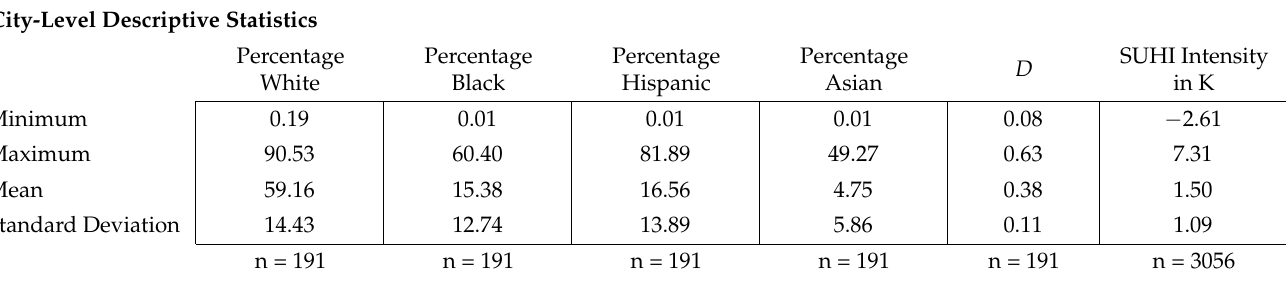
Table 4. City-level descriptive statistics for each